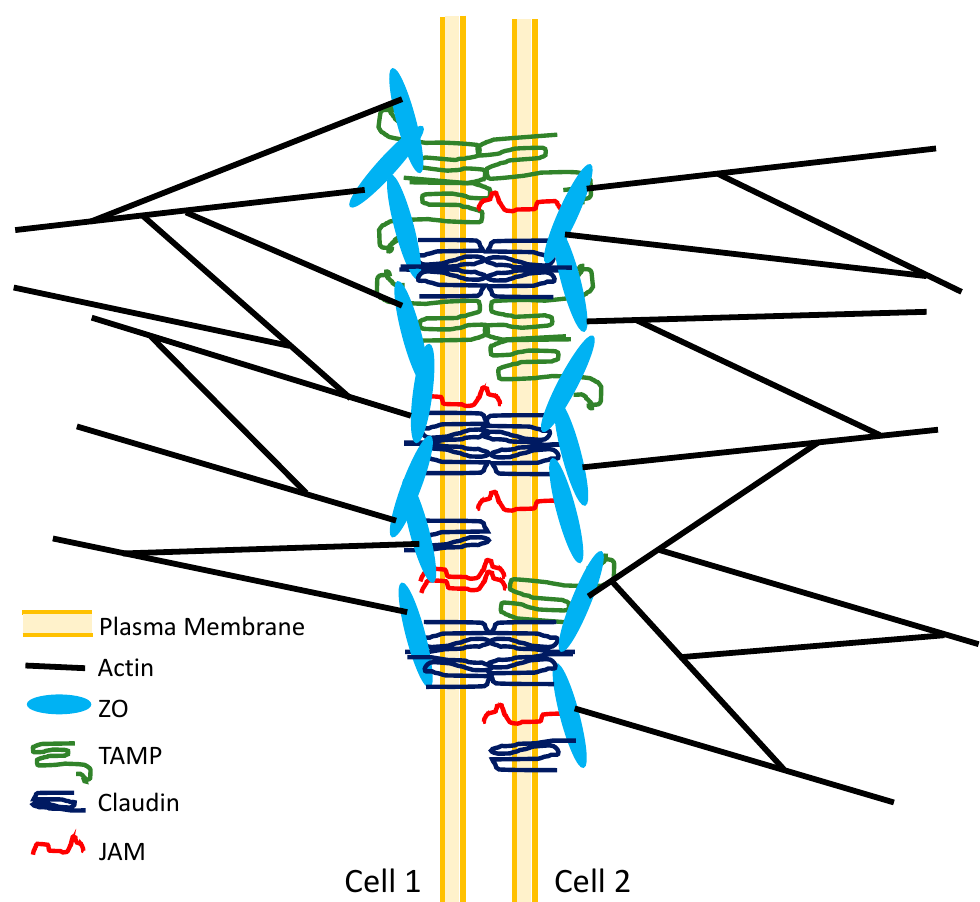
Figure 1. Side view of a model of tight junction supramolecular organization. The tight junction membrane proteins form homo- and heterodimers within the same membrane and between apposing membrane faces [28,32–37]. The tight junction membrane proteins are crosslinked to the underlying actin cytoskeleton and microtubular network (not shown) by ZO proteins [16,19,38–46] and cingulin, respectively. The claudin proteins organize into an anastomosing network of antiparallel double strands [28,32,33]. Occludin proteins are localized to bicellular junctions and exhibit a modest preferential localization at claudin strand branching sites [62]. See the text for a more complete description of the proposed tight junction organization. The possible involvement of lipids in the tight junction structure is not shown in this figure.